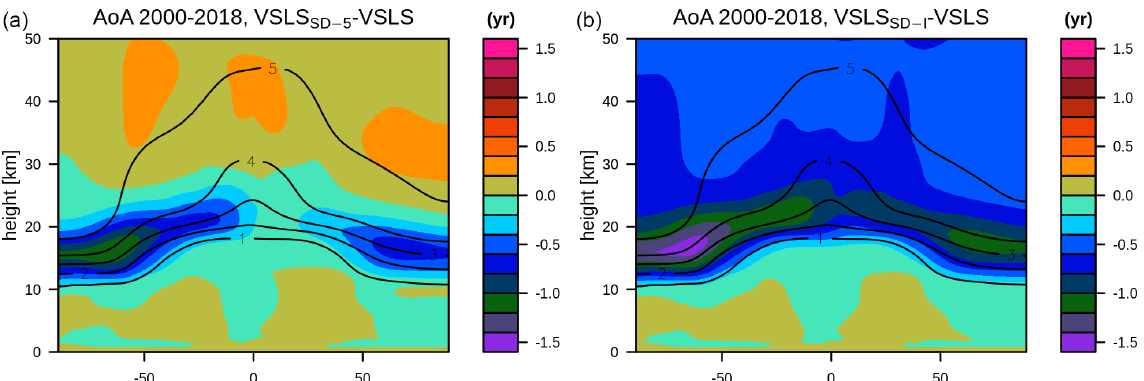
Figure 6. Shading: 2000–2018 difference in the model age-of-air [year] between the nudged and free-running integrations. (a) The difference between VSLS SD-5 and the ensemble mean VSLS, and (b) the difference between VSLS SD-I and the ensemble mean VSLS. Contours show the age-of-air in the ensemble mean free-running VSLS for